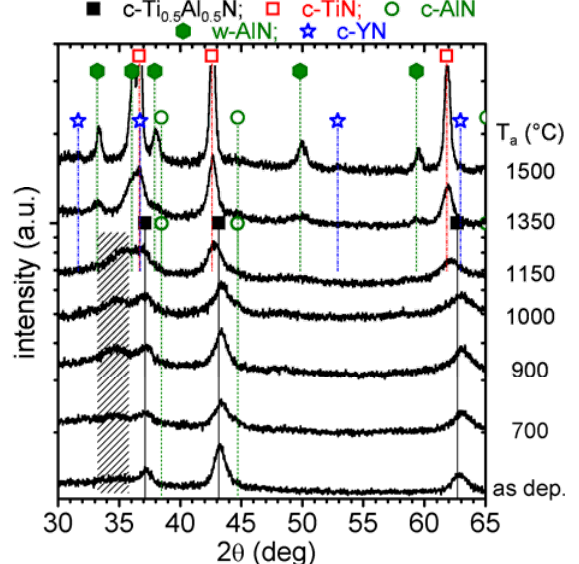
Al Y N in the (a) as 0.41 0.57 0.02